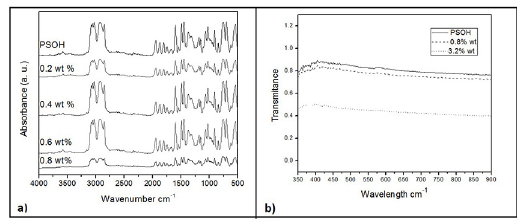
Figure 4. PSOH and composites spectra: a) FTIR, b) UV-vis.